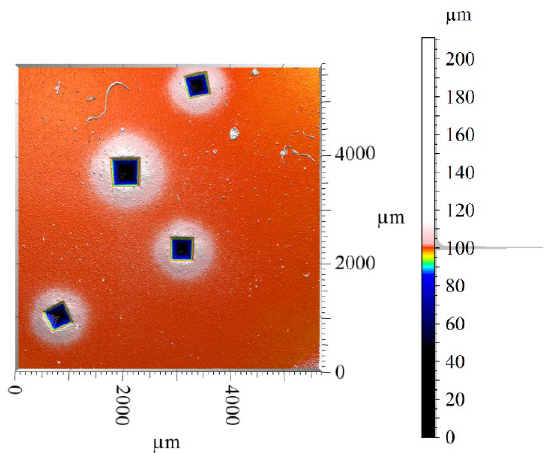
Figure 10. Three-dimensional view of the stitched topography in test case B. Stitching size: 3 ×